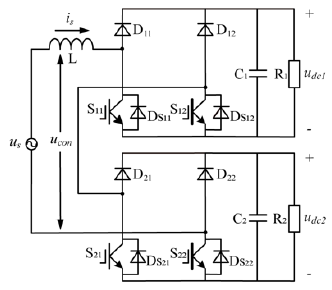
Figure 4. Single-phase two-stage cascaded bridgeless rectifier for TCMC.